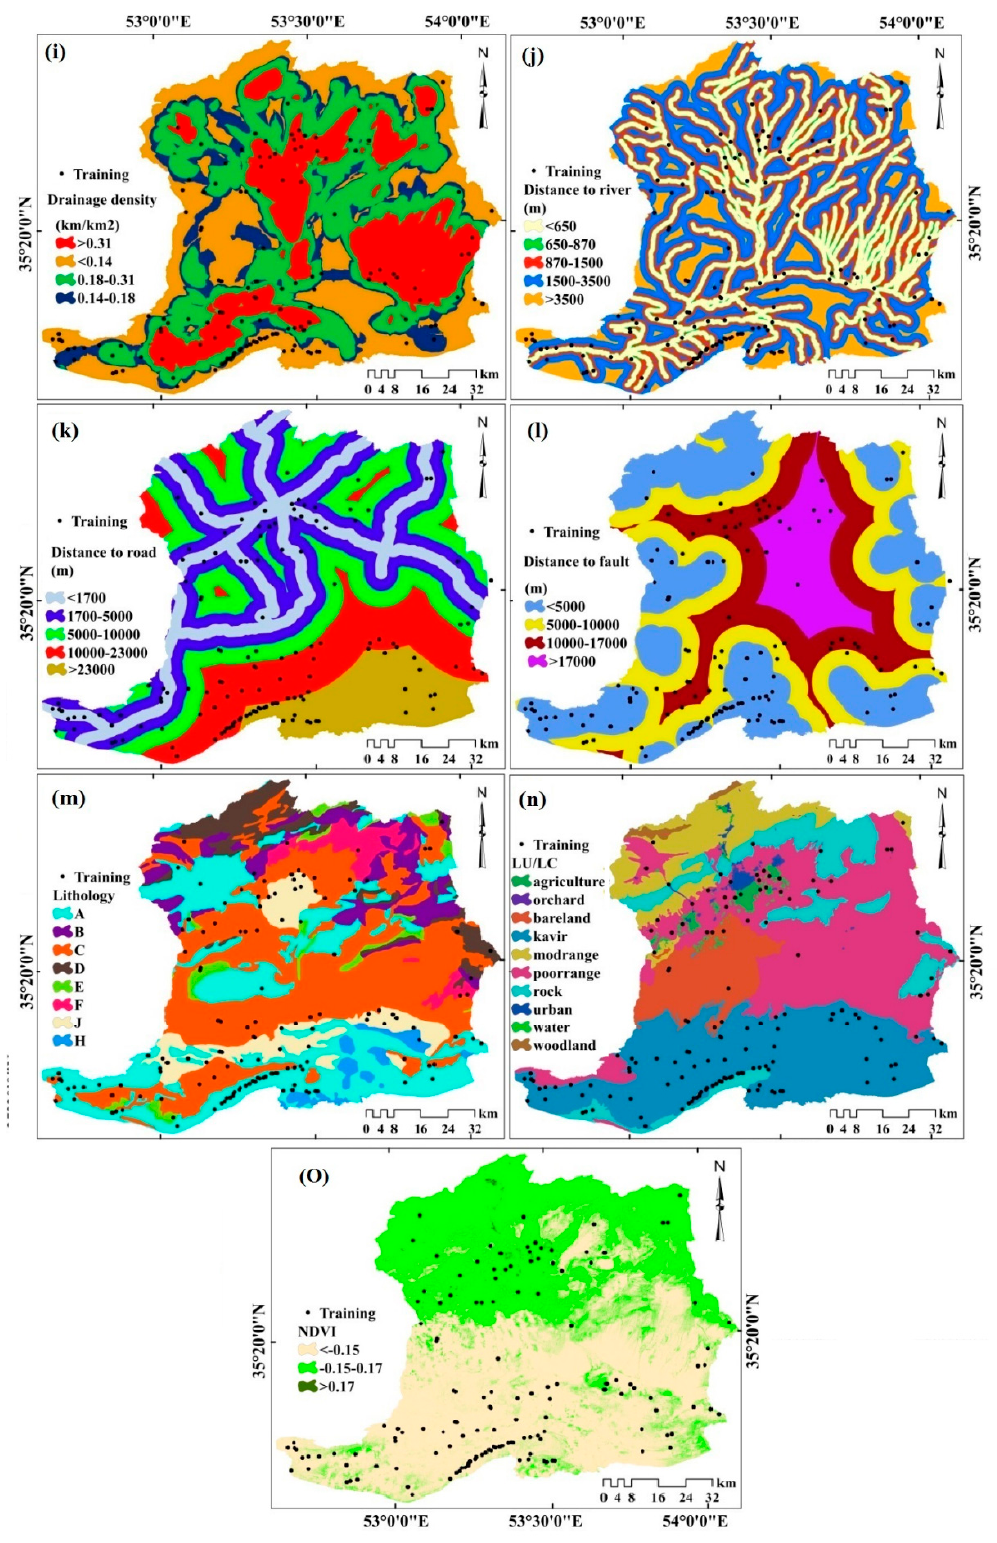
Figure 4. Gully erosion conditioning factors. ( a ) Elevation, ( b ) slope, ( c ) aspect, ( d ) plan curvature, ( e ) stream power index (SPI), ( f ) topographical wetness index (TWI), ( g ) rainfall, ( h ) soil type) ( i ) drainage density, ( j ) distance to river, ( k ) distance to road, ( l ) distance to fault, ( m ) lithology, ( n ) land use/land cover, and ( o ) normalized difference vegetation index (NDVI).